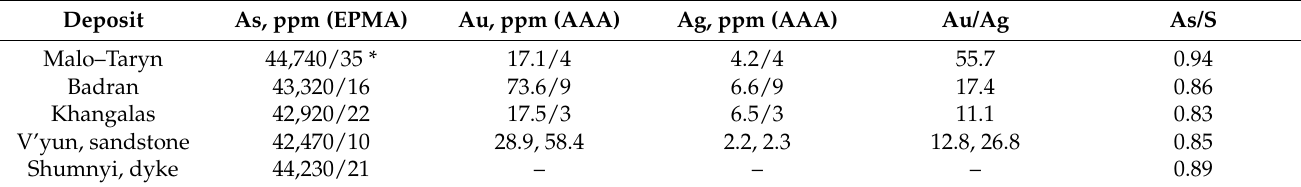
Table 7. Mean values of As, Au, and Ag in the arsenopyrite1 of the studied OGDs, central YKMB.